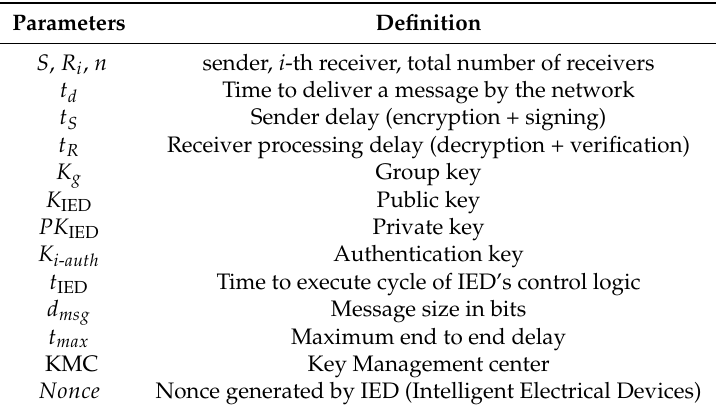
Figure 3. Network Model. Table 1. Notation